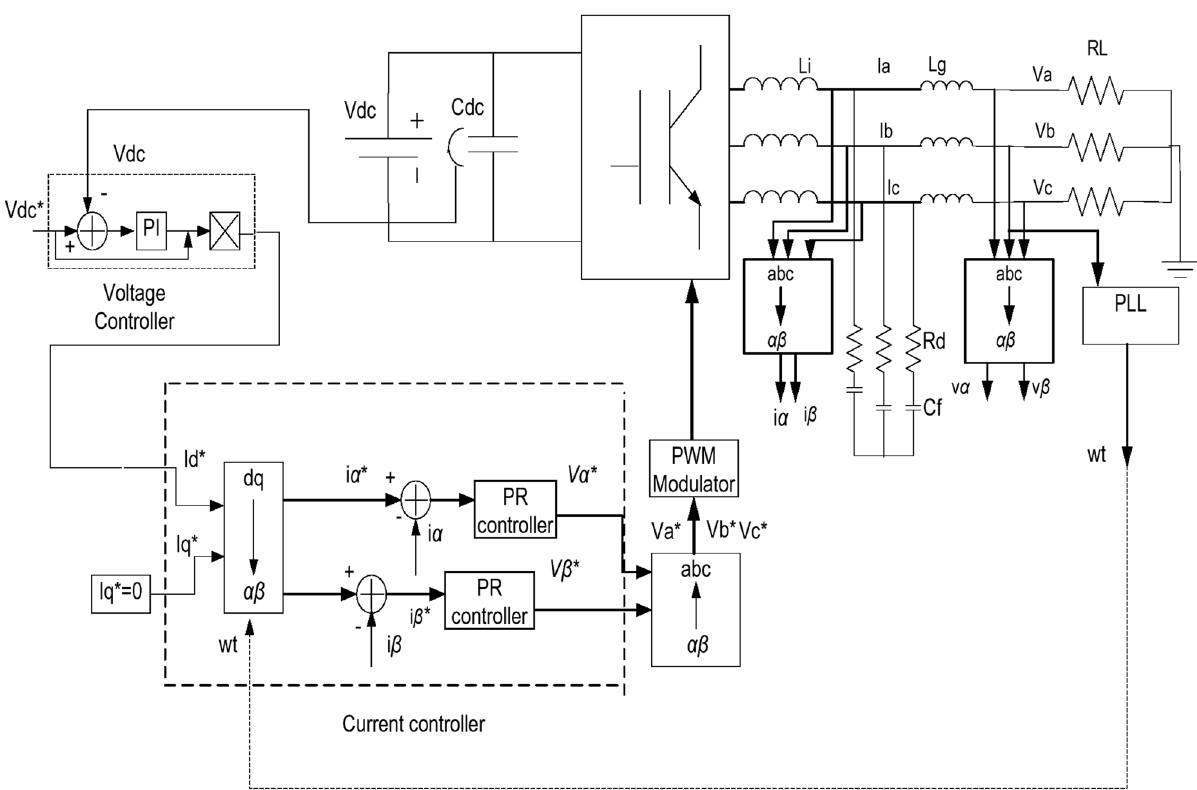
Figure 4: Standalone PV system with its control scheme in α - β reference